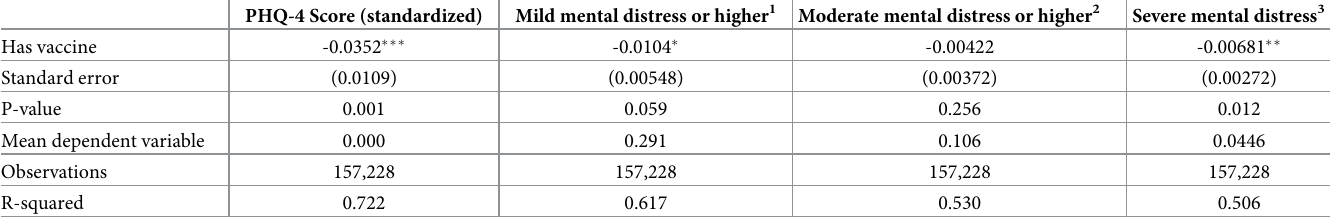
Table 2. Fixed effects regression